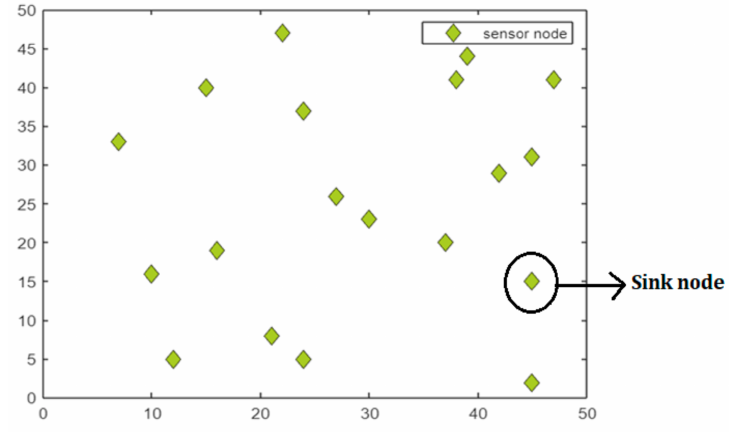
Figure 11. Position of sensor nodes.